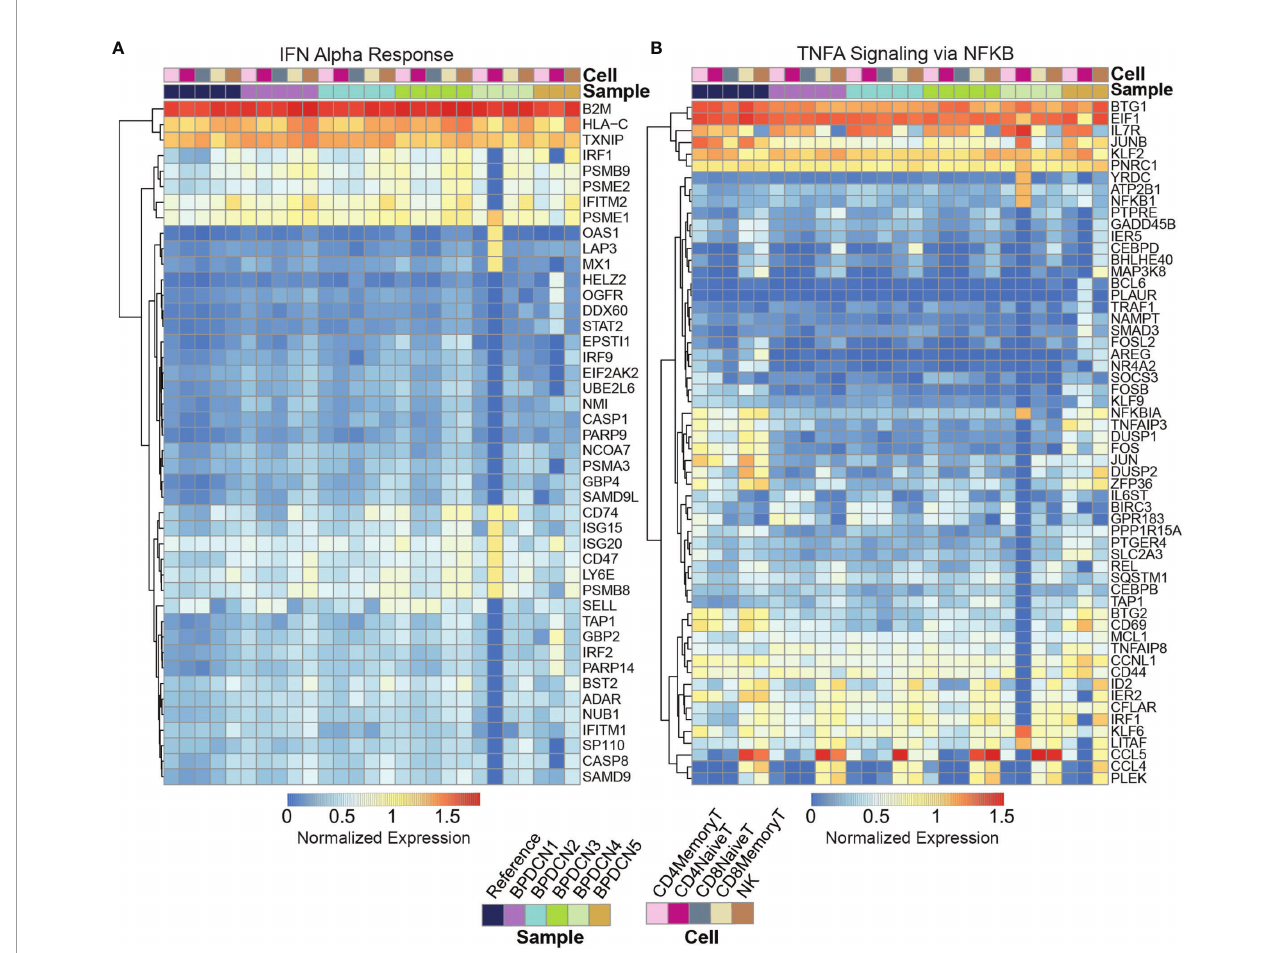
FIGURE 4 | Expression of IFNA and TNFA associated gene sets. (A) Heatmap shows log expression values for genes in the IFN Alpha Response gene set (rows) for each sample and cell type (columns), clustered by row. Genes were fi ltered to those signi fi cant (p < 0.05) after multiple testing correction with an expression value for one sample above 0.5. Red indicates higher expression and blue indicates lower expression. (B) Heatmap shows log expression values for genes in the TNFA Signaling via NFKB gene